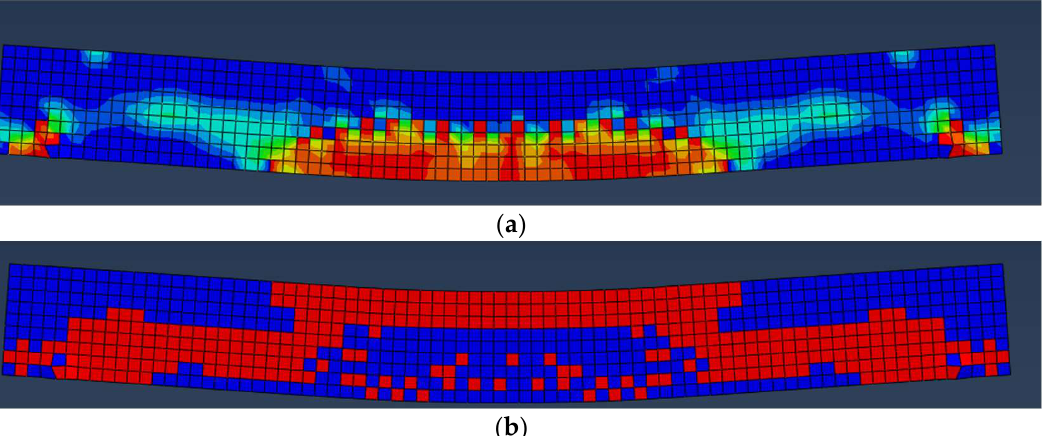
Figure 22. Analytical damage pattern of LWCM1. ( a ) Tensile damage of LWCM1; ( b ) Yield points of LWCM1.